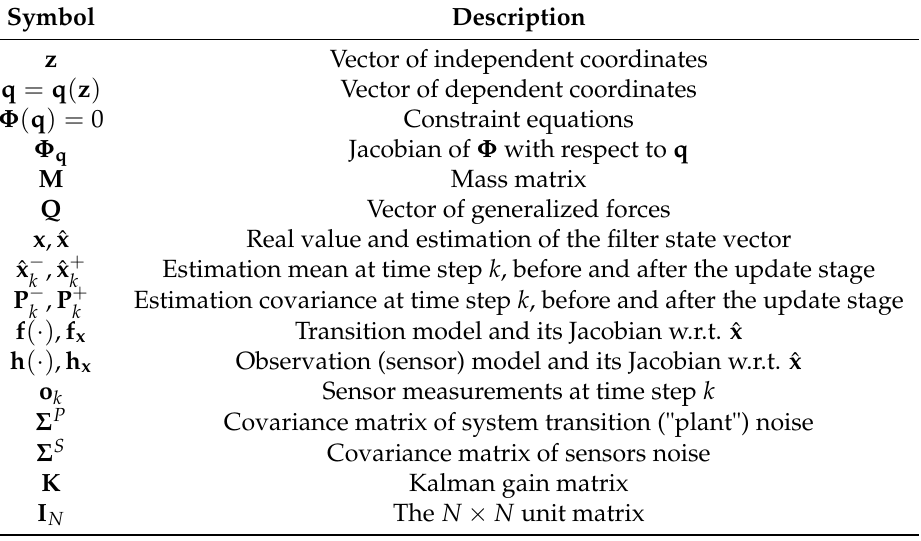
Table 2. Notation